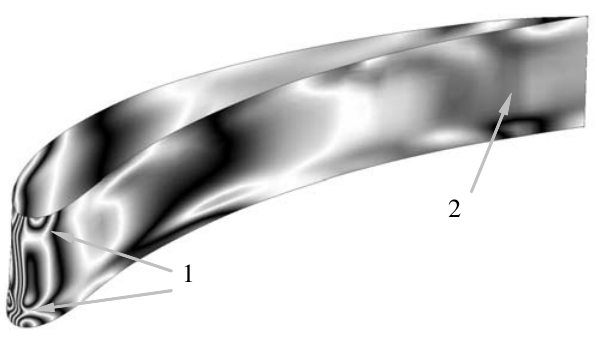
Fig 4. Analysis of surface created by means of mirror reflection: 1 – discrepancies in surface caused by insufficient accuracy of point cloud; 2 – discrepancies caused by gap in point cloud